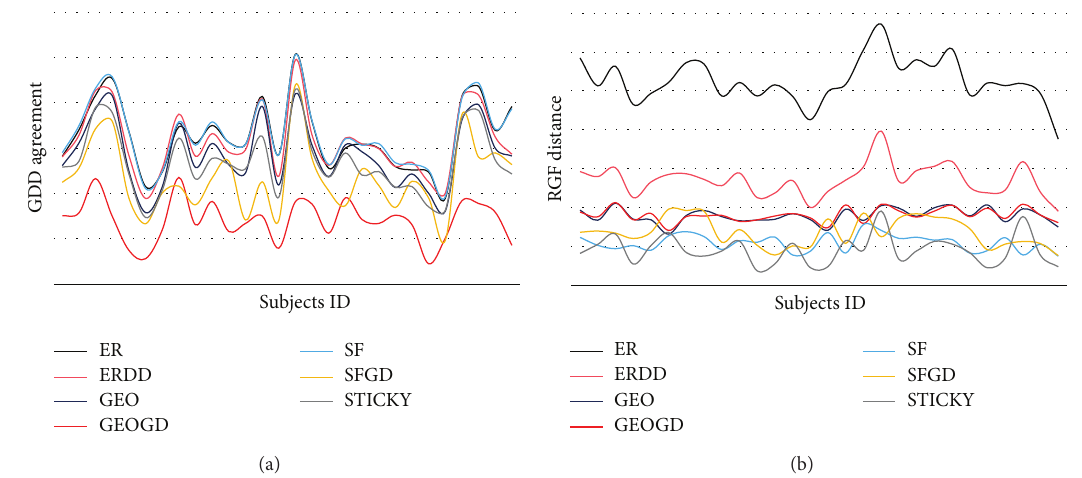
Figure 3: The local graph properties of 7 network models for 28 adolescents. The 𝑥 -axis is subject index. (a) GDD-agreement. Higher value indicates higher similarity. (b) RGF-distance. Higher value indicates lower similarity.